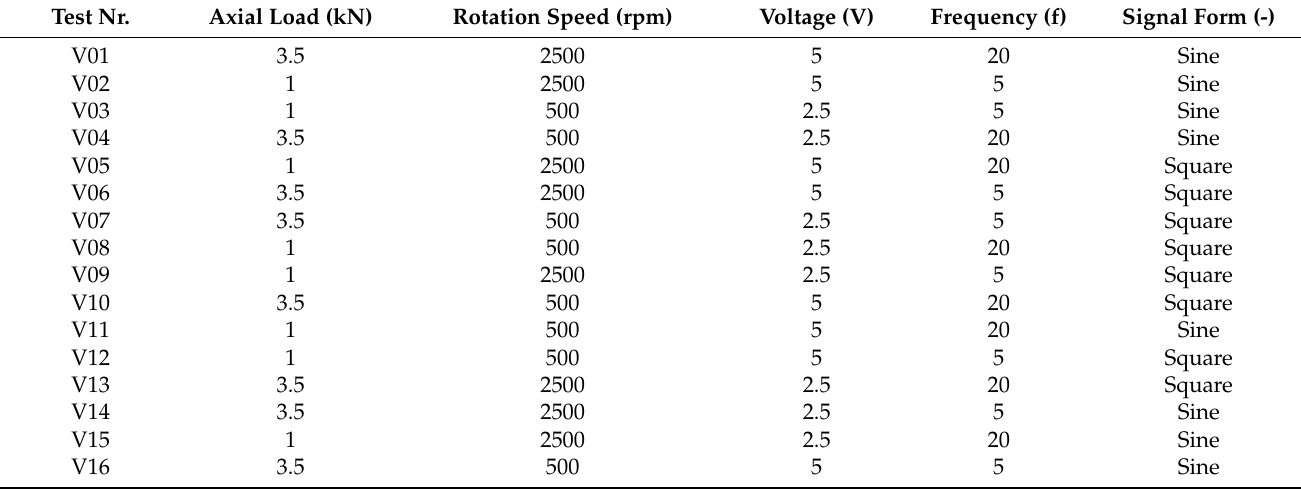
Table A1. Operating conditions of all